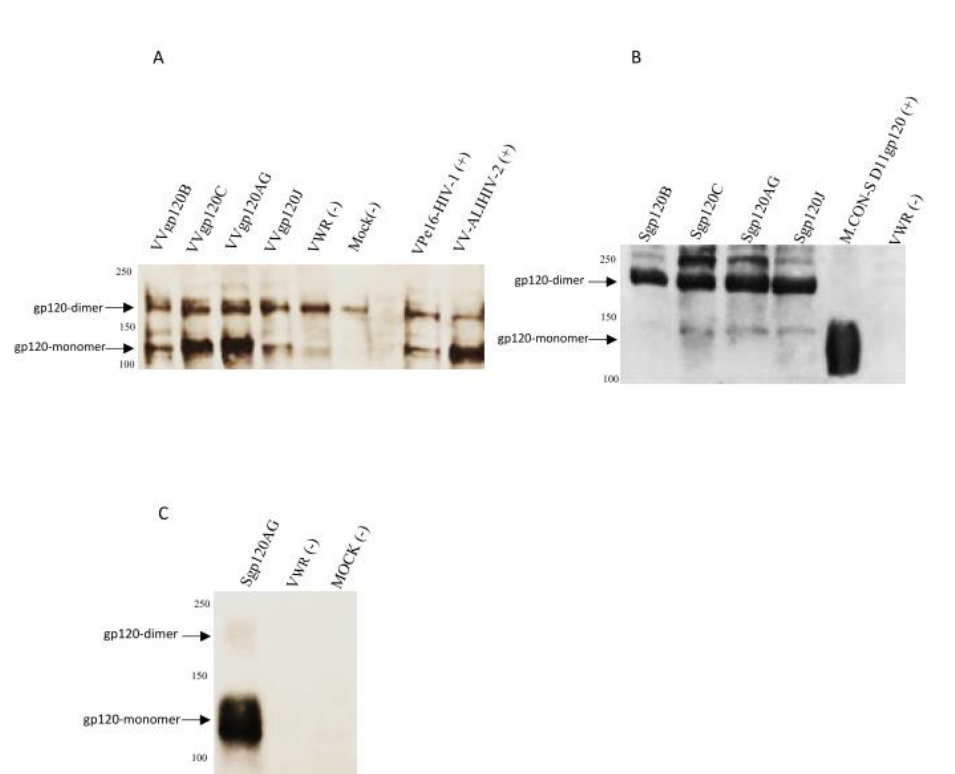
Figure 1. Western blot analysis of envelope gp120t expressed by recombinant Vaccinia viruses. HeLa cells were infected with recombinant Vaccinia viruses expressing envelope gp120t from HIV-1 clades B (VVgp120B), C (VVgp120C), J (VVgp120J), and CRF_AG (VVgp120AG). Cell lysates ( A ) and cell supernatants ( B ) were incubated with sera from HIV-1 infected individuals. Supernatant from cells infected with VVgp120AG was also incubated with bNAb 447-52D (anti-V3) ( C ). Positive controls for these experiments were recombinant Vaccinia viruses expressing the HIV-1 envelope (vPE16), the HIV-2 envelope (rVV/ALI), and a consensus group M envelope gp120 (M.CON.S-D11). Negative controls were uninfected cells (mock) and cells infected with the WR strain of Vaccinia virus (V WR ). Molecular weight is indicated in KDa on the left.